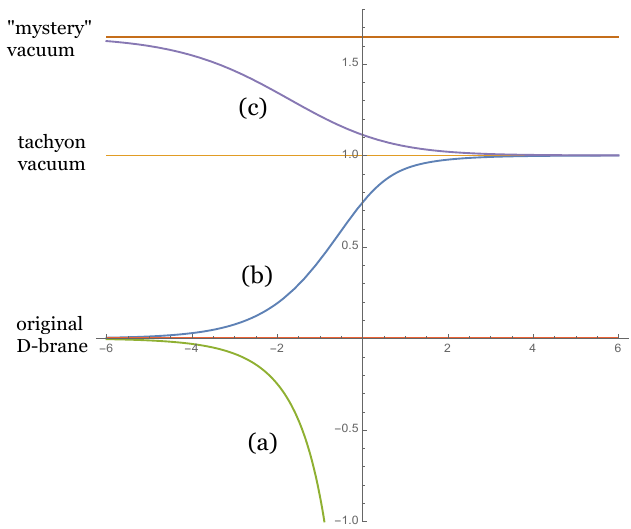
Figure 6 . Pro(cid:12)les of the ghost number zero tachyon as a function of x + 2 [ (cid:0) 6 ; 6] for three solutions: case (a) is when the tachyon rolls in the negative direction, case (b) is when the tachyon rolls towards the tachyon vacuum (already shown in (cid:12)gure 2), and case (c) is a solution which rolls to the tachyon vacuum from the \other side." The initial con(cid:12)guration for case (c) appears to represent a new vacuum